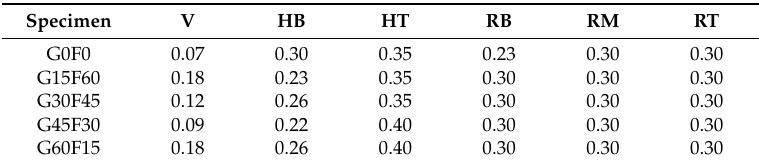
Table 10. Regression Parameter a .